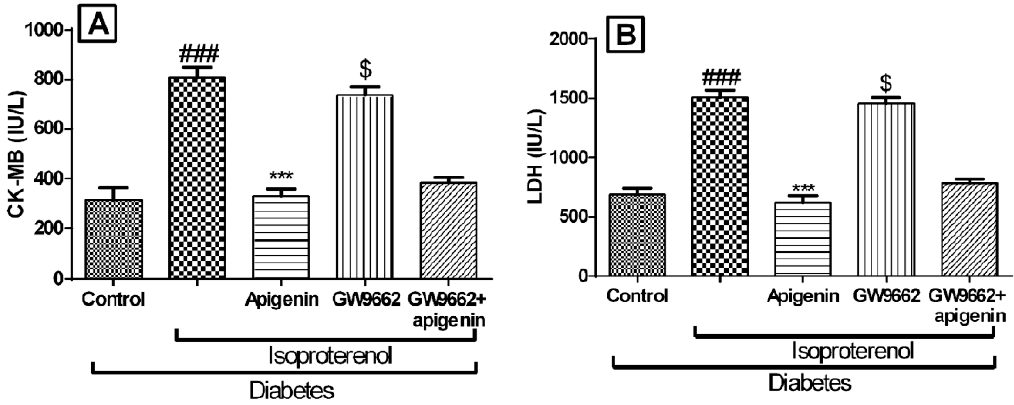
Figure 4. Effects of apigenin on cardiac injury markers in STZ–isoproterenol-treated rats. ( A ) Creatine kinase on myocardial bundle (CK-MB); ( B ) Lactate dehydrogenase (LDH). The data are expressed as mean ± SEM. The significance was determined by a one-way ANOVA followed by the Bonferroni’s post hoc test: *** p < 0.001 compared to diabetic isoproterenol; ### p < 0.001 compared to diabetic control; $ p < 0.001 compared to diabetic isoproterenol + apigenin (IU: International unit).